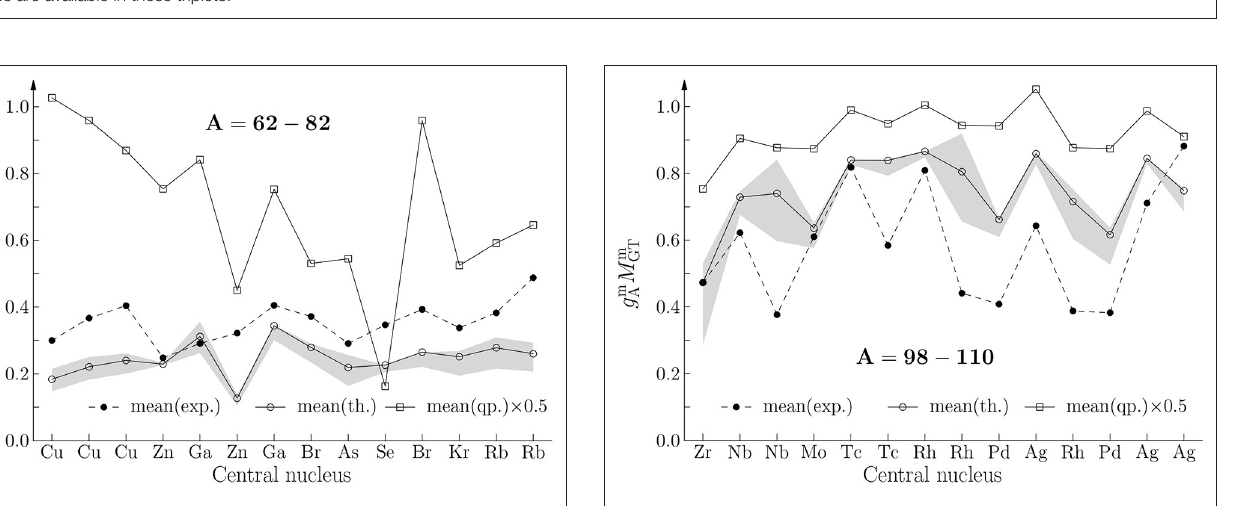
FIGURE 2 | Experimental log ft values of the left-branch and right-branch β transitions in four triplets of nuclei. It is also shown that no data on the decays of the 2 − states are available in these triplets.